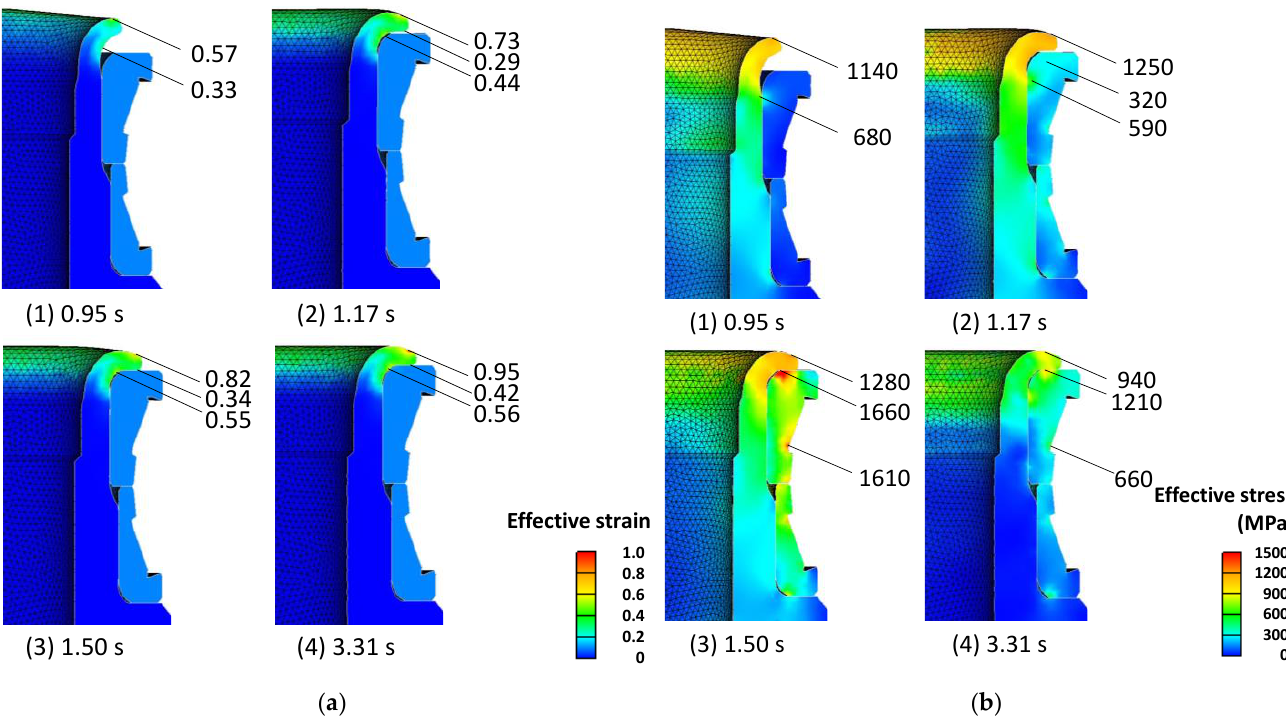
Figure 11. Predicted effective strains and stresses: ( a ) effective strain; ( b ) effective stress.